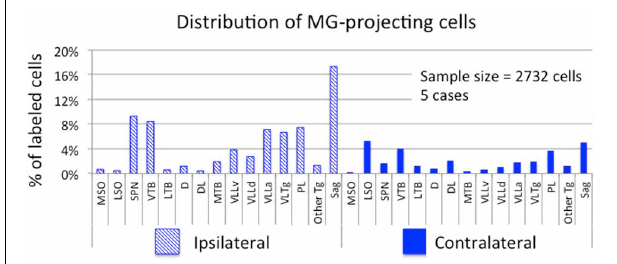
FIGURE 3 | Graph showing the distribution of labeled cells in subcollicular auditory nuclei after injection of a retrograde tracer into the medial geniculate nucleus (MG). Each bar shows the percentage of cells (averaged across 5 cases) located in each nucleus. Cross-hatched bars show values for nuclei ipsilateral to the MG injection site and solid bars show values for contralateral nuclei. “Other Tg” indicates scattered cells in intermediate anddorsalnucleiofthelaterallemniscusaswellasrostrallyand caudally adjacent areas not included in the paralemniscal area. See list for other abbreviations.